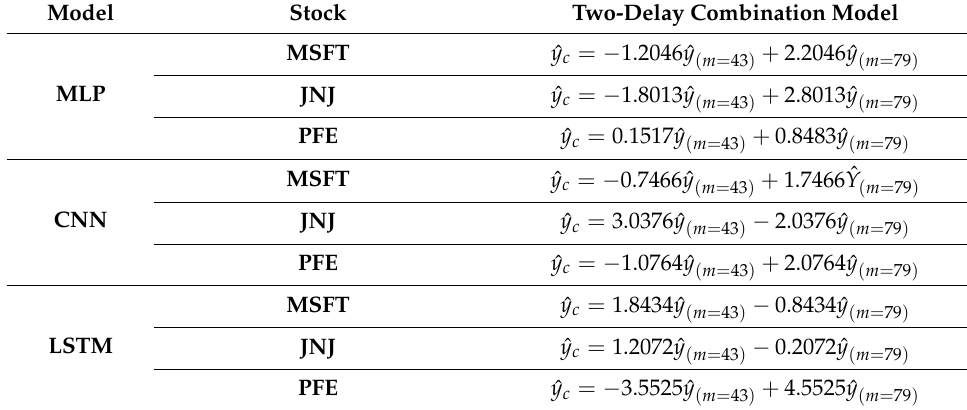
Table 7. Prediction models of the MSFT, JNJ and PFE